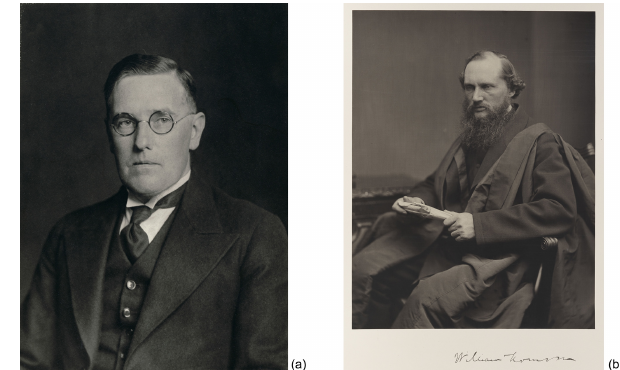
Figure 1. (a) Arthur Thomas Doodson CBE, DSc, FRS, FRSE (1890–1968) photographed in 1933 by Walter Stone- man. (b) Sir William Thomson (1st Baron Kelvin of Largs) OM, GCVO, PC, FRS, FRSE (1824–1907) photographed in 1871 by Thomas Annan. © National Portrait Gallery,